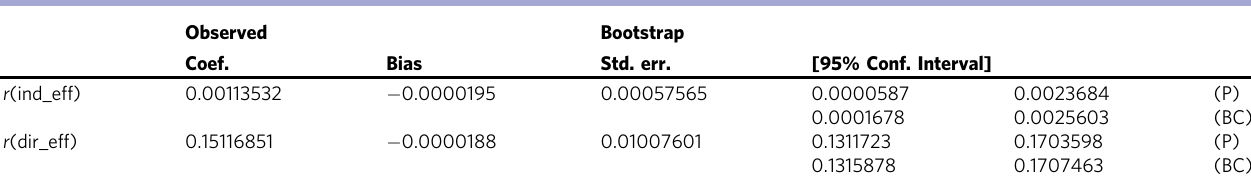
Table 4 Summary statistics of the bootstrap